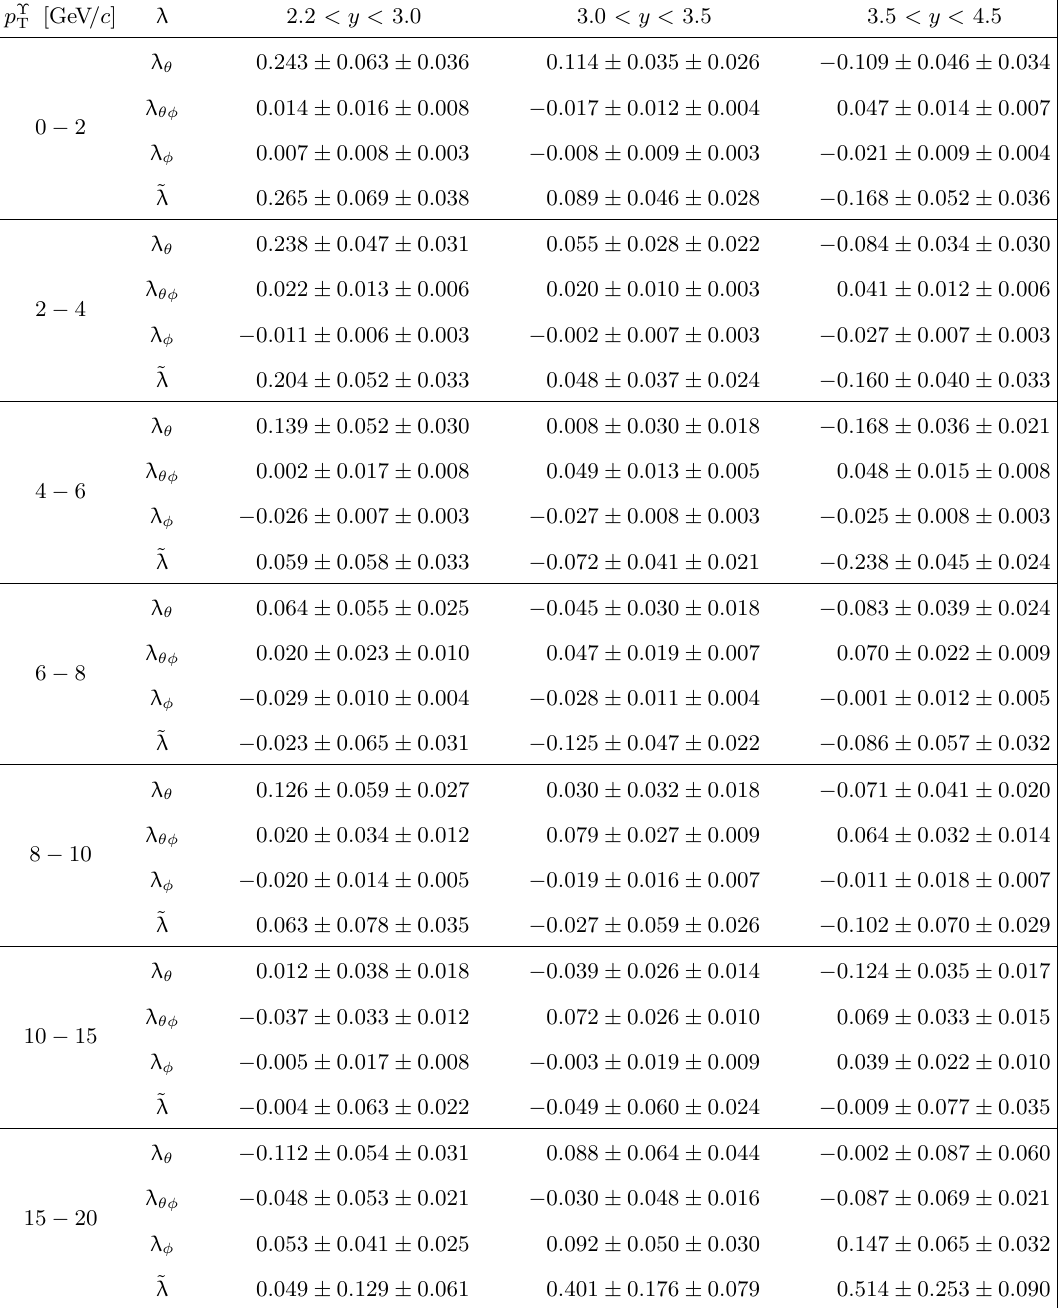
Table 4 . Values of (cid:21) (cid:18) , (cid:21) (cid:18)(cid:30) , (cid:21) (cid:30) and ~ (cid:21) measured in the CS frame for the (cid:7)(1S) produced at p s = 7 TeV. The (cid:12)rst uncertainty is statistical and the second systematic.